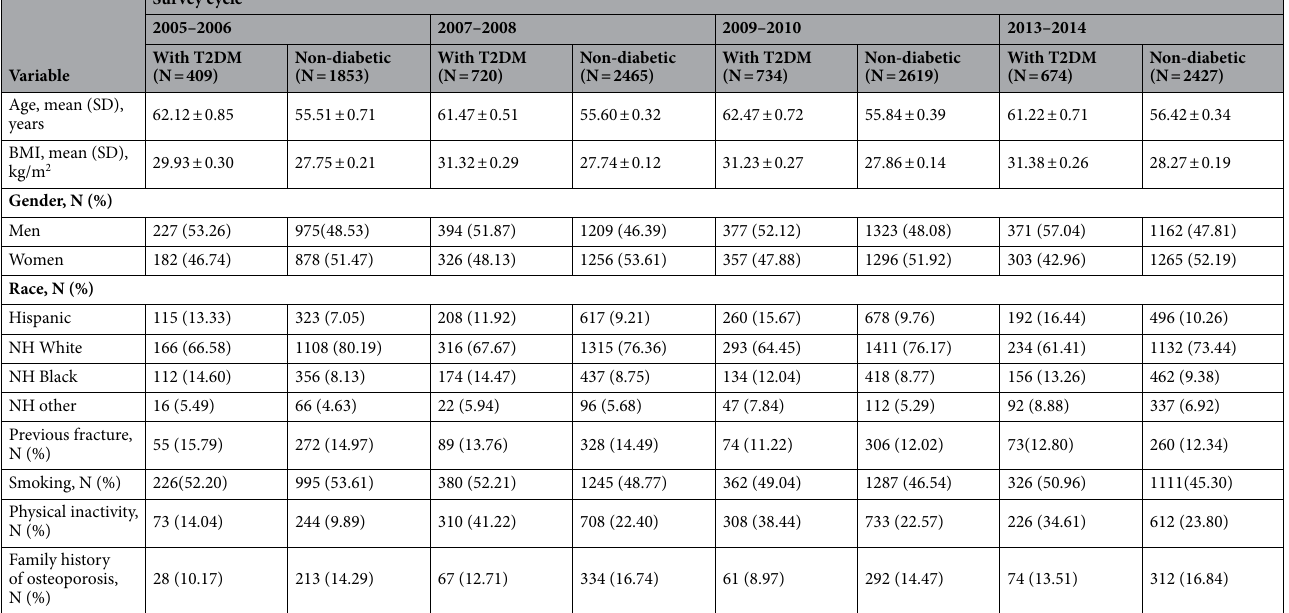
Table 1. Weighted characteristics of subjects aged 40 and older, among T2DM patients and non-diabetic population in 4 NHANES (2005–2006, 2007–2008, 2009–2010, and